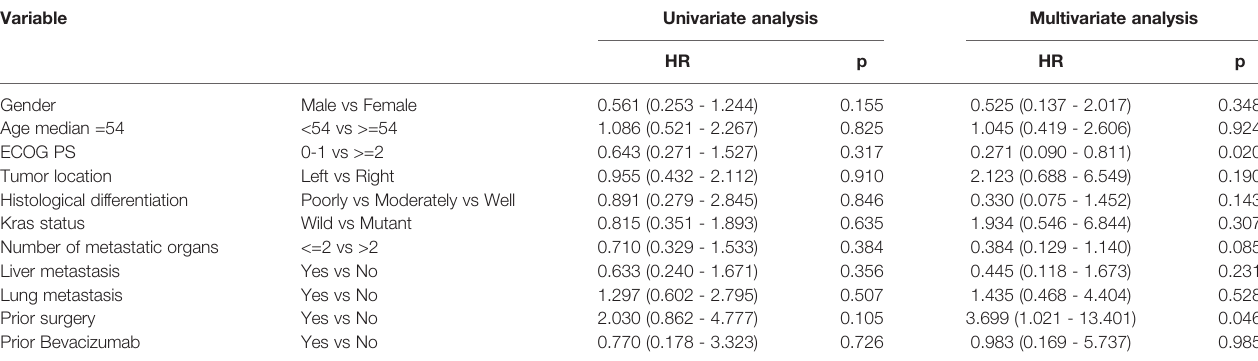
TABLE 4 | Univariate analysis and multivariate analysis of clinical variable for the prediction of overall survival.